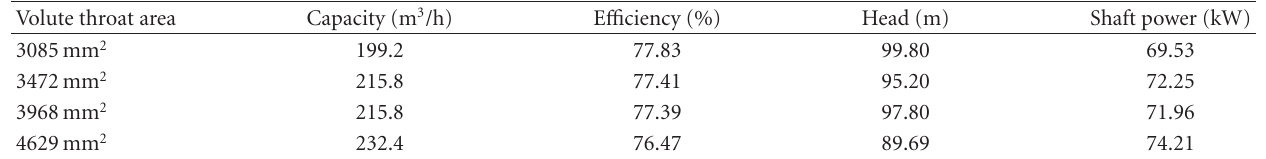
Figure 3: (a) Meshes within impeller. (b) Meshes within volute. (c) Meshes of a cross-section. Table 2: List of pump BEPs at di ff erent volute throat areas.